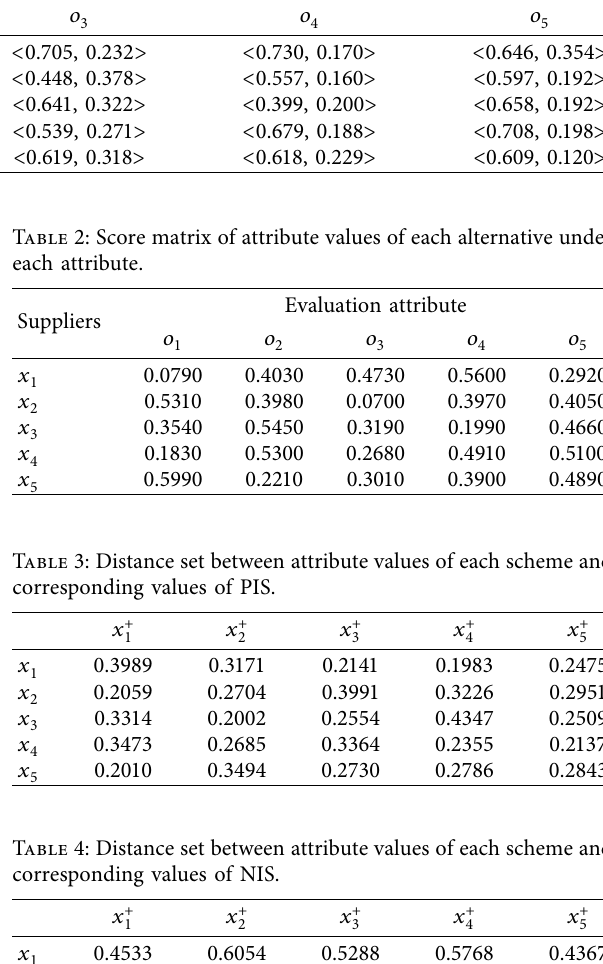
Table 1: Attribute evaluation value of each alternative supplier o